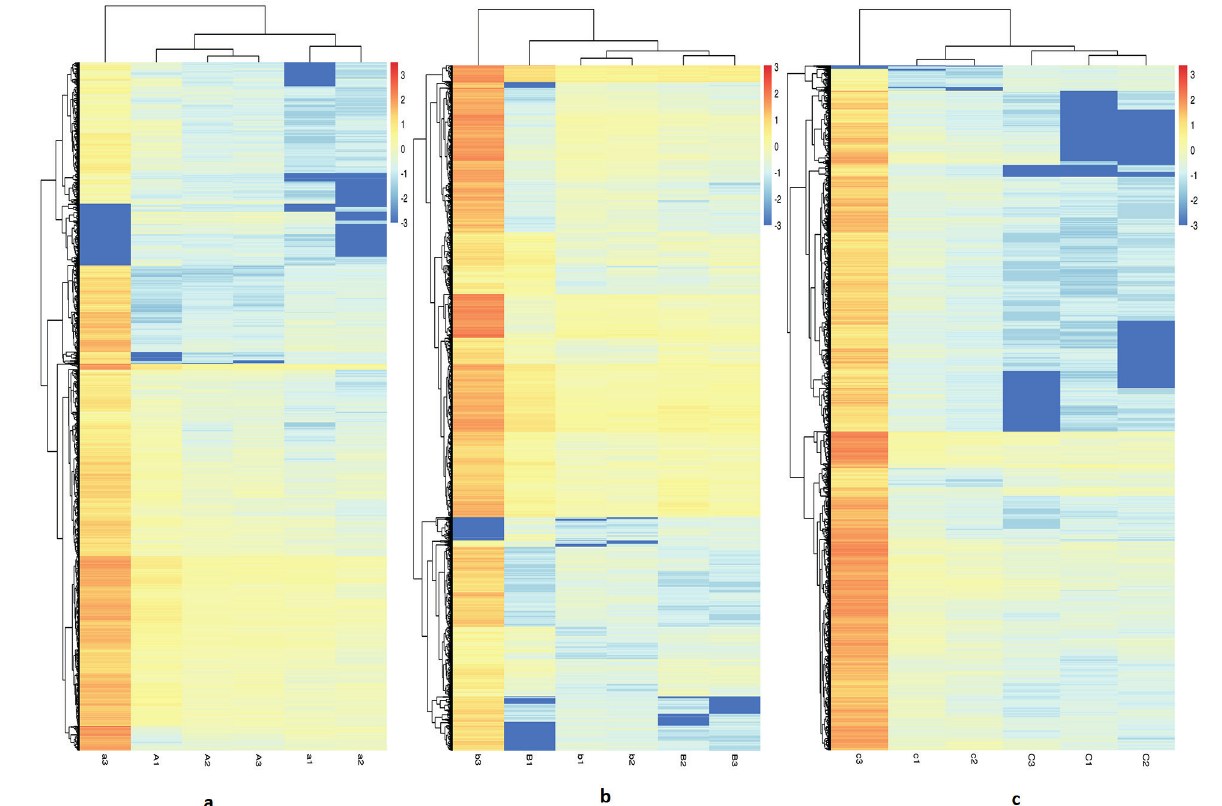
Figure 2 - Hierarchical cluster analysis heat‐map of differential C m CGG methylation sites between ATRA-treated and control in the stage of differential development. Using MethylRAD technology combined with Paired-End sequencing on a HiSeq X Ten platform, a label containing C m CGG sites was proposed as the reference sequence. The individual enzyme reads were mapped to the reference sequence of the C m CGG sites using the SOAP program (version 2.21, parameter: -M4-v2-r0). For assessing the methylation level of differential methylation sites between ATRA-treated and control for the three biological replicates, cluster analysis was performed to further reveal the changes in C m CGG sites methylation level ( n =18, 3 groups, 3 ATRA-treated samples vs . 3 control samples). Brown indicates hypermethylation sites, and blue indicates hypomethylation sites respectively ( P <0.05, log FC >1). ( a ):at E 13.5, ( b ): E14.5, ( c ): at 2